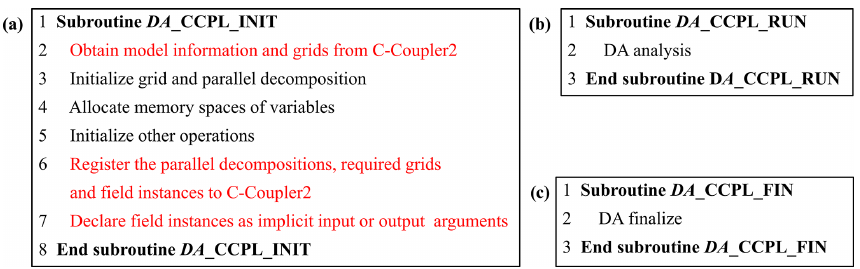
Figure 6. Example of the driving subroutines in a DA algorithm. (a) Initialization driving subroutine. (b) Running driving subroutine. (c) Finalization driving subroutine. The name of the DA algorithm “DA” is used as the prefix of the three driving subroutines; different suffixes are used for distinction. Black font indicates original functionalities of the DA algorithm, while red font indicates additional operations to perform online data exchanges between the model and DA